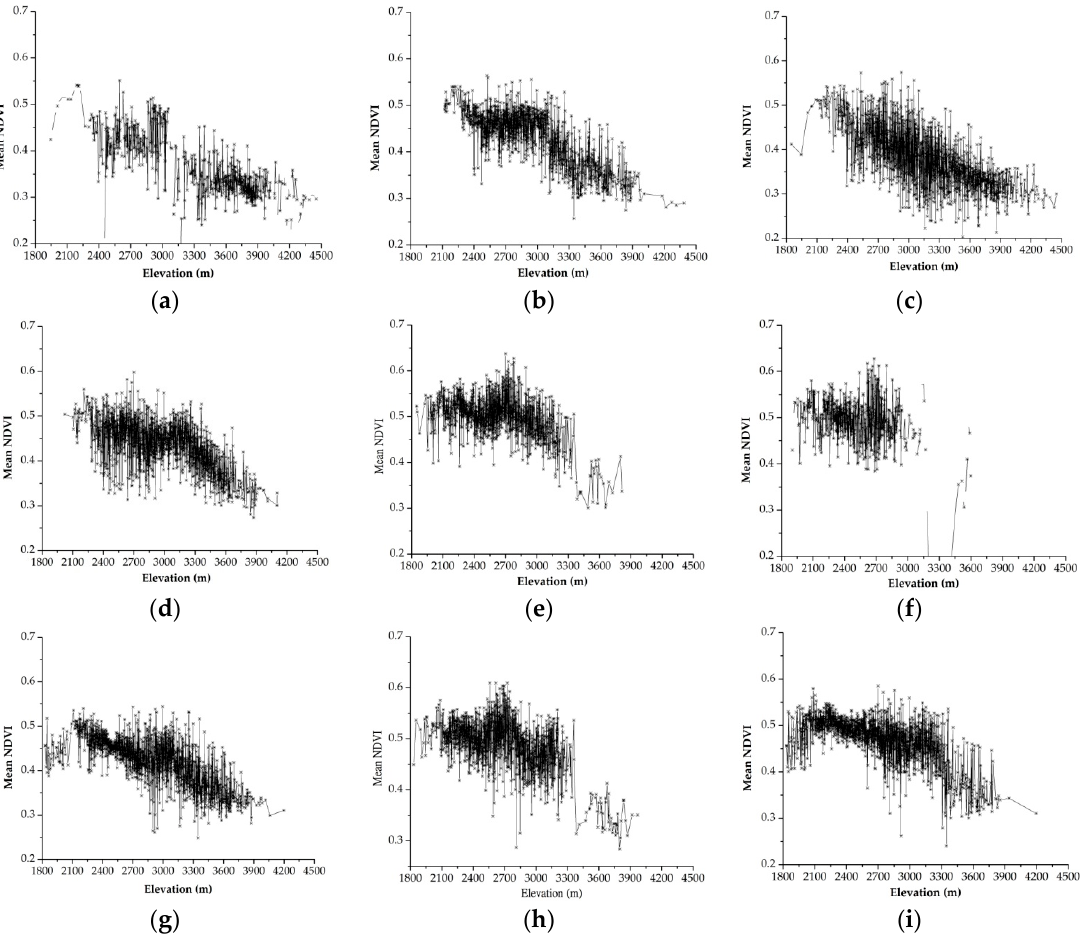
Figure 5. The scatter plots (spline connected) show the density and distribution of each vegetation type per elevation over the Virunga Volcanoes Massif; ( a ) Alpine; ( b ) Bamboo; ( c ) Bush-ridge; ( d ) Hagenia-Hypericum; ( e ) Herbaceous; ( f ) Meadow-Savannah; ( g ) Mixed-forest; ( h ) Mimulopsis; and ( i ) Neubutonia. Table 4. Change of mean and standard deviation of NDVI per aspect and per vegetation cover type.